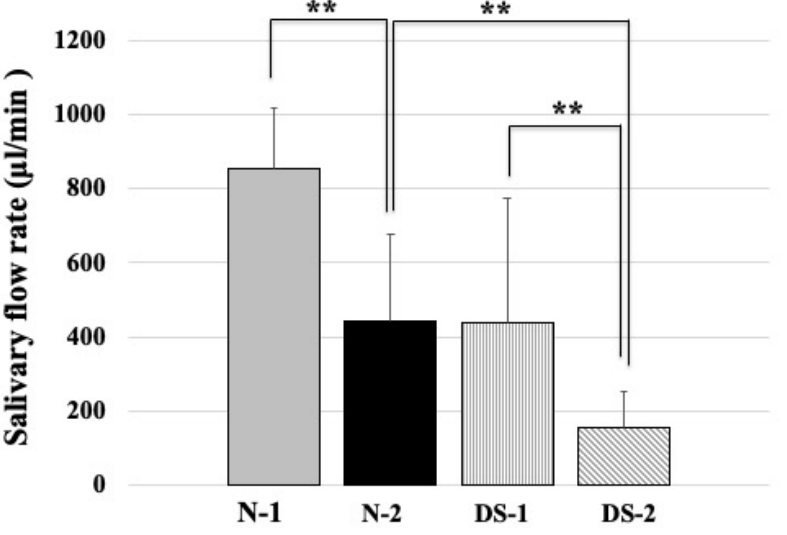
Figure 2. Comparison of total salivary protein concentrations between the Down syndrome (DS) and normal (N) groups. The DS and N groups were subdivided according to age, with the first group consisting of DS (DS-1) and normal (N-1) subjects under 20 years of age, and the second group consisting of DS (DS-2) and normal (N-2) subjects over 40 years of age. The sex composition and mean age of the study groups are shown in Table 1. One-way ANOVA test results of compar- ing salivary flow rate in four groups and the pairwise comparison using Scheffe’s test for all four groups. ** p < 0.01; F-value 38.91. ** p < 0.01; F-value